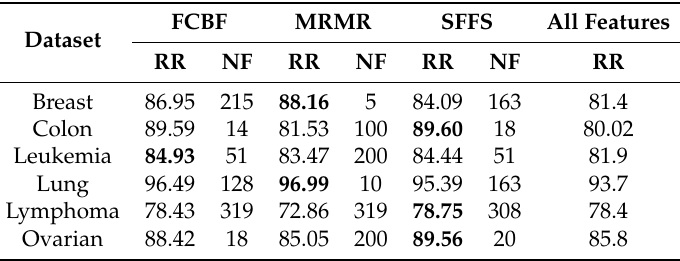
Table 3. Best results of heuristic search algorithms for feature selection with DT classifier.